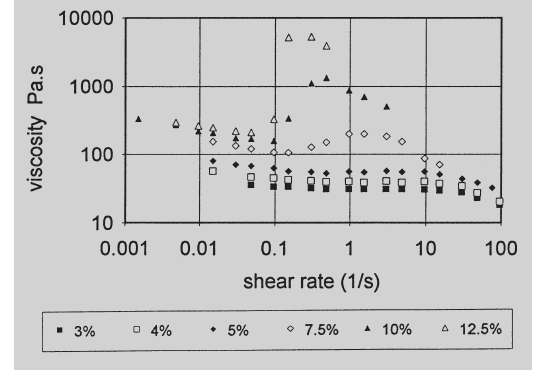
Figure 1 (left): Viscosity curves of Araldite GY 260 with different con- centrations of Aerosil 380 (WRG, cone-plate, 25°C). Figure 2: Viscosity curves of M20000 with different concentration of Aerosil 380 (WRG, cone-plate,